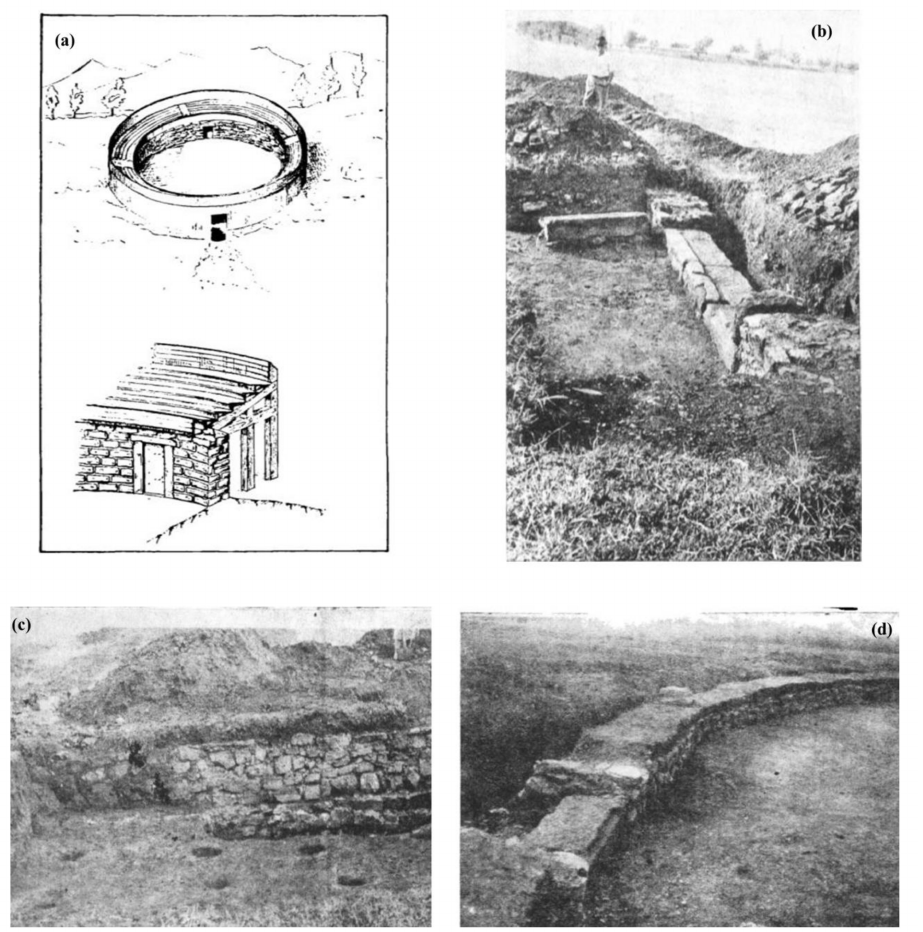
Figure 4. The amphitheatre of Micia ( © [54]): ( a ) Ideal reconstruction; ( b ) West main entrance; ( c ) Exterior of the stone precinct of the arena and the marks of the supporting pillars of the wooden stands; ( d ) Arena enclosure